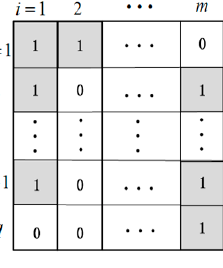
Figure 8. 2D accumulation coding for a channel allocation scheme (Case 2).